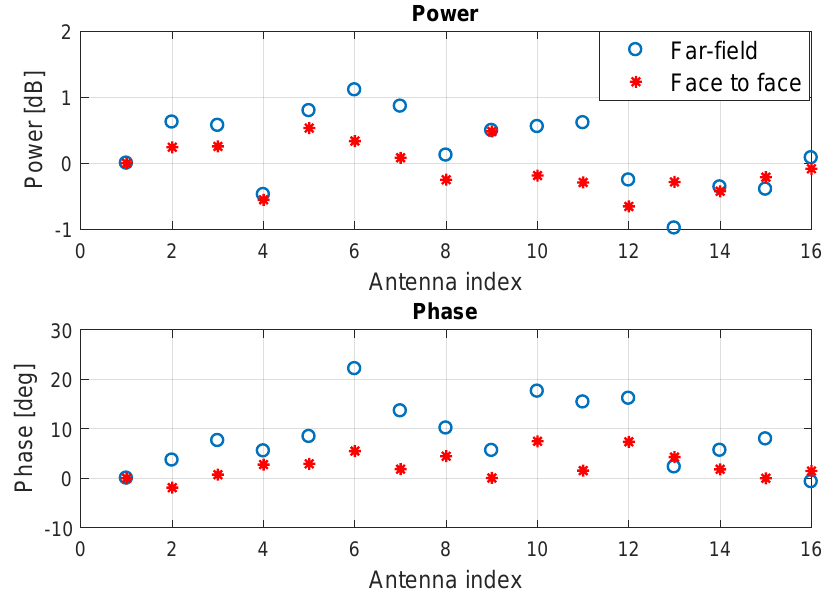
Figure 4. A comparison between the “far-field element on/off” and “face-to-face” calibration mea- surement comparison. The power and phase values were normalized to the first antenna element for both